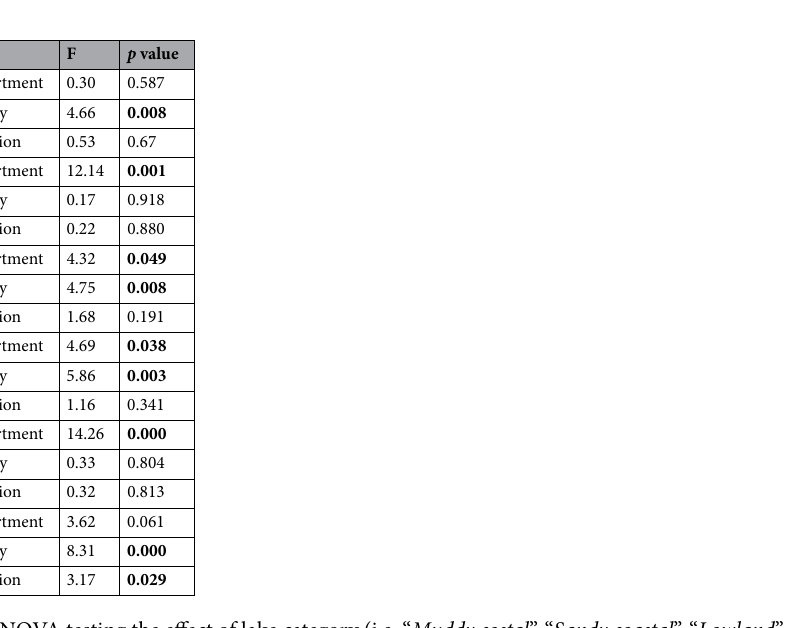
Table 2. Two-way ANOVA testing the effect of lake category (i.e. “ Muddy costal ”, “ Sandy coastal ”, “ Lowland ” and “ Glacier ”), ecosystem compartment (i.e. aquatic vs. terrestrial) and their interaction on δ 15 N, δ 13 C, AFDM and N content in the substrate, S. (i.e. sediment/soil), as well as on δ 13 C and N content in aquatic and terrestrial vegetation, V., in shallow Arctic lakes in North Spitzbergen (Svalbard Islands). Bold values indicate a significant effect, p < 0.05. Statistics refer to values shown in Fig.